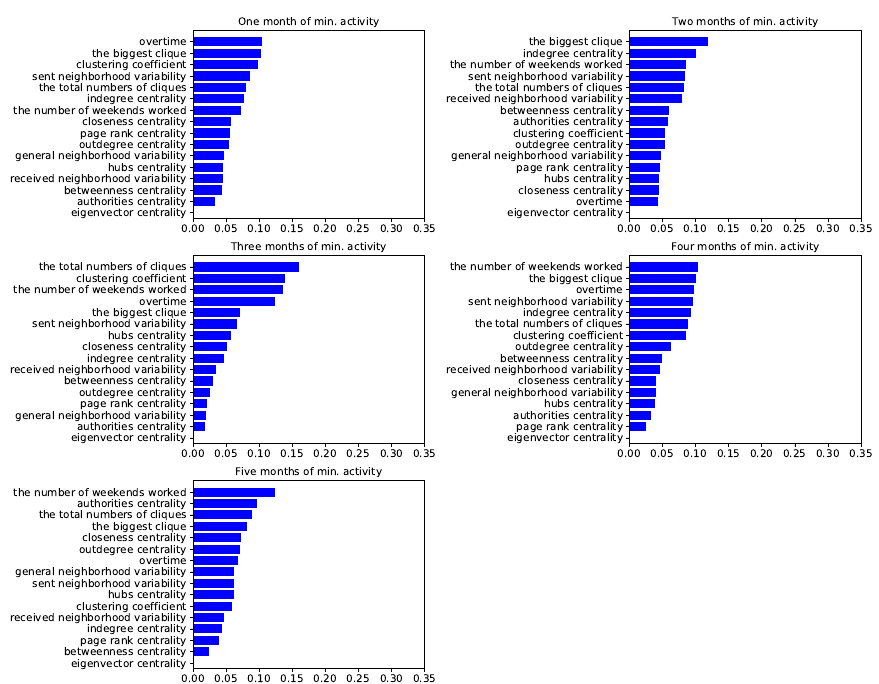
Figure A3. Features importance (Gini importance) for the Random Forest which uses the full set of features for the manufacturing company dataset with two levels of the hierarchy.